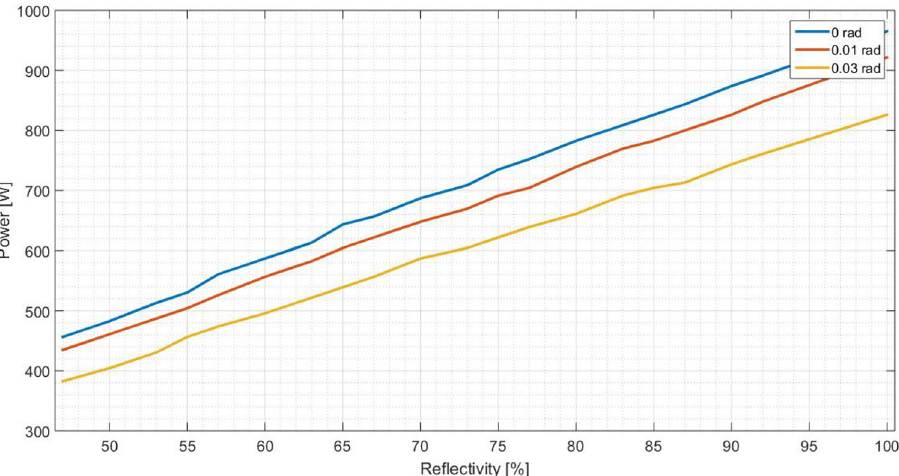
Figure 12. Output power in function of the reflectivity of the flat concentrator, for different optical error values.